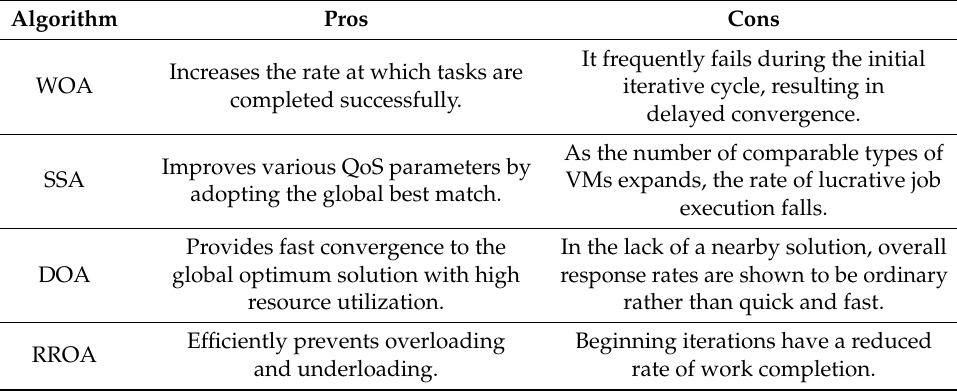
Table 5. Pros and cons of modern